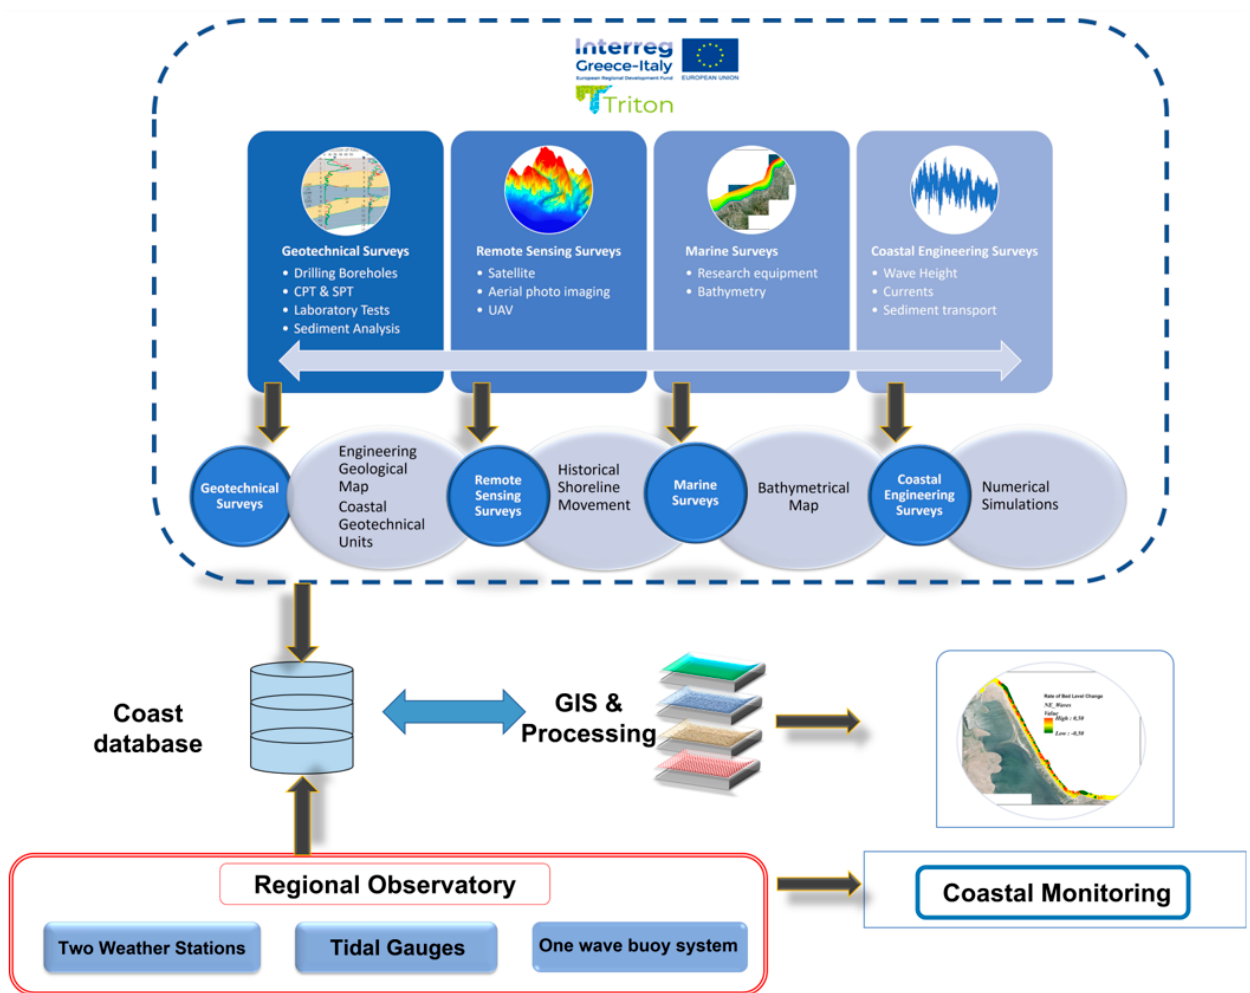
Figure 2. Survey design plan combined with a regional observatory for coastal monitoring of the su ff ered shoreline.